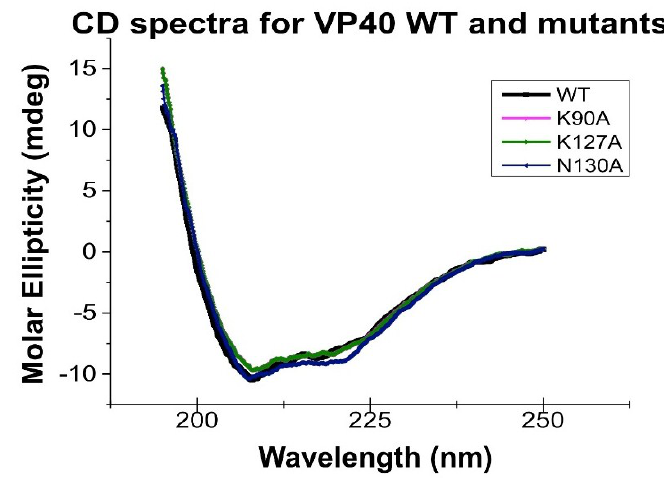
Figure 3. Circular dichroism spectra of VP40 and mutants employed in this study. The spectra were taken on a JASCO 815 CD spectrometer scanned from 195–250 nm in a 1 mm quartz spectrophotometer cell. Each measurement was performed with 5 mg of indicated protein and was performed in triplicate to yield the mean representative